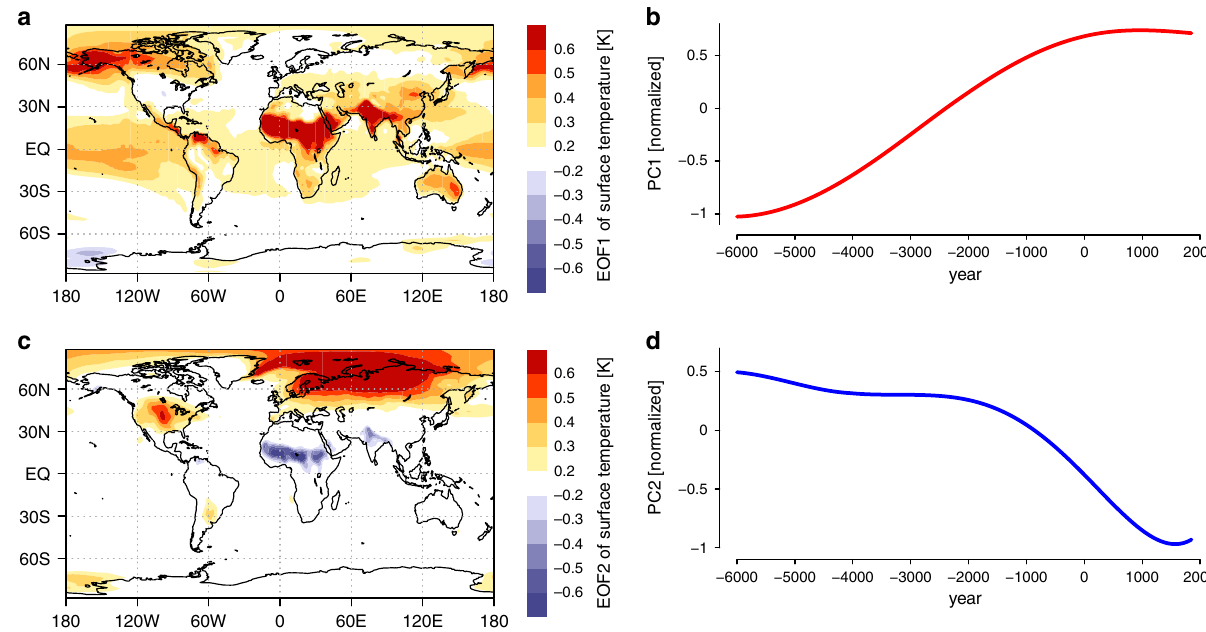
Fig. 2 The simulated warming and cooling mode in the transient Holocene simulation. First two spatial empirical orthogonal function (EOF) modes (a,c) and corresponding normalized smoothed principal components (PCs) (b,d) based on the simulated annual 2 m temperature using the MPI-ESM data. The red and blue curves in the right panels show the low-pass fi ltered PCs. The explained variances of the annual (not low-pass fi ltered) temperature modes are: 18% and 9%. Panels (a) and (b) show the spatial pattern and temporal evolution of the warming mode and panels (c) and (d) correspond to the cooling mode.